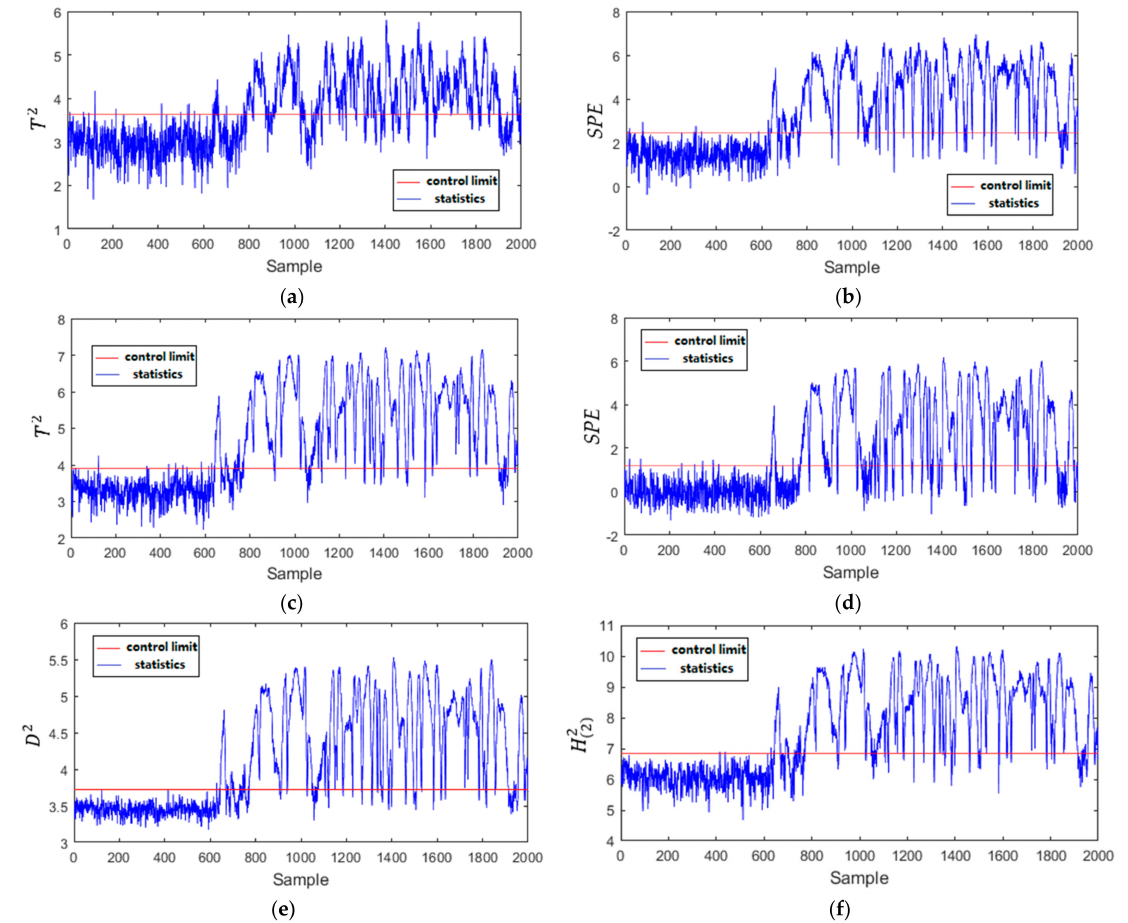
Figure 11. Monitoring results of Fault 26 in Mode 2: ( a ) LNS-PCA ( T 2 ); ( b ) LNS-PCA ( SPE );